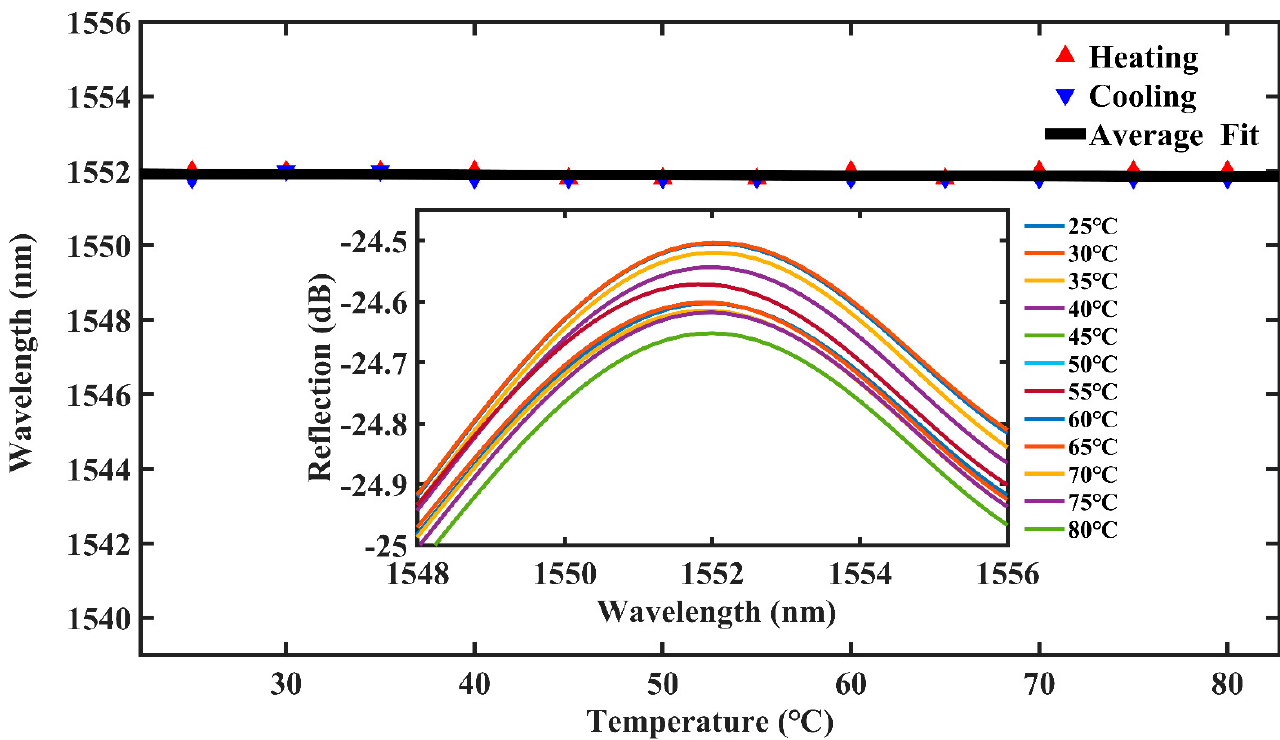
Figure 9. Experiment setup of the temperature sensing system based on cascaded FPIs.